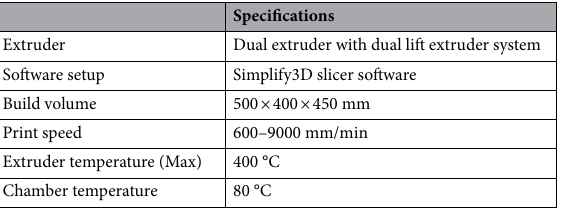
Table 1. Technical specifications for German RepRap X500®printer.